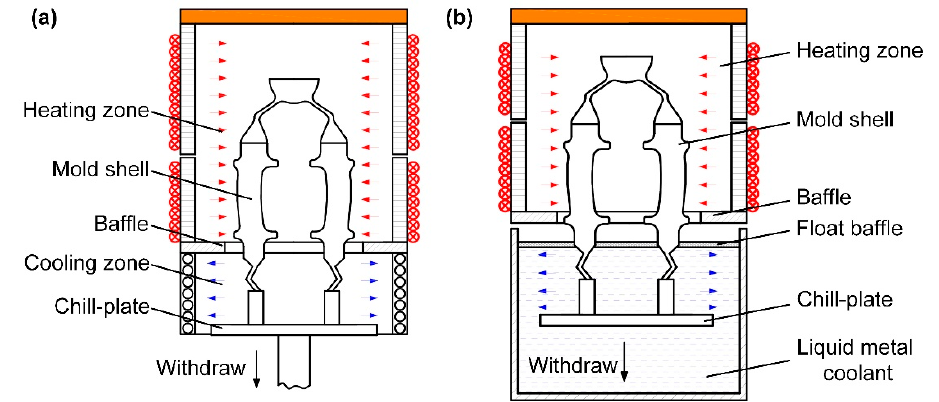
Figure 1. Schematic of the two types of directional solidification techniques: ( a ) HRS and ( b ) LMC.